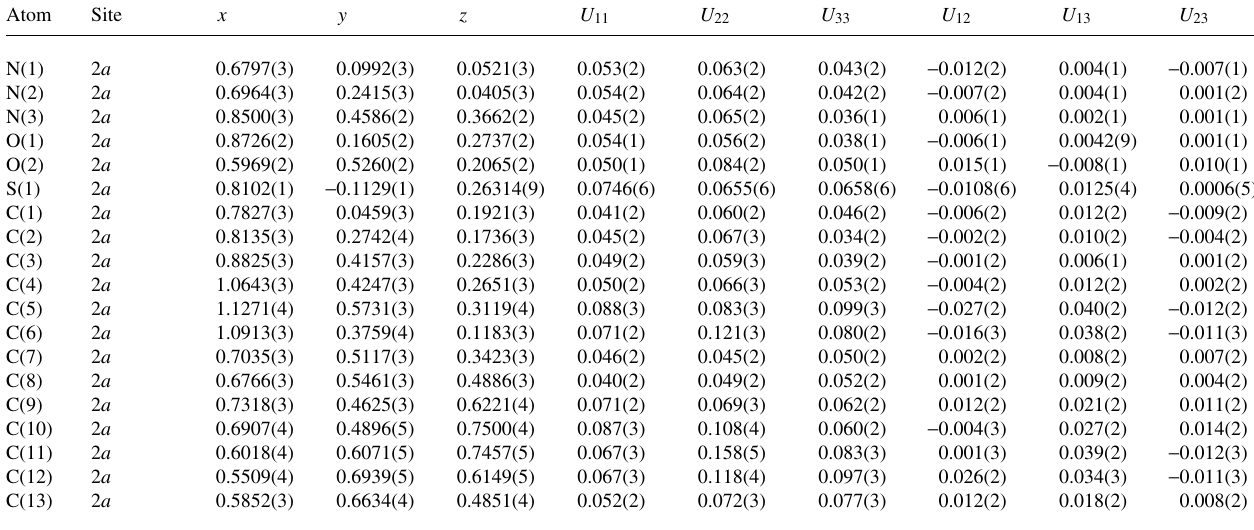
Table 3. Atomic coordinates and displacement parameters (in Å 2 ) .